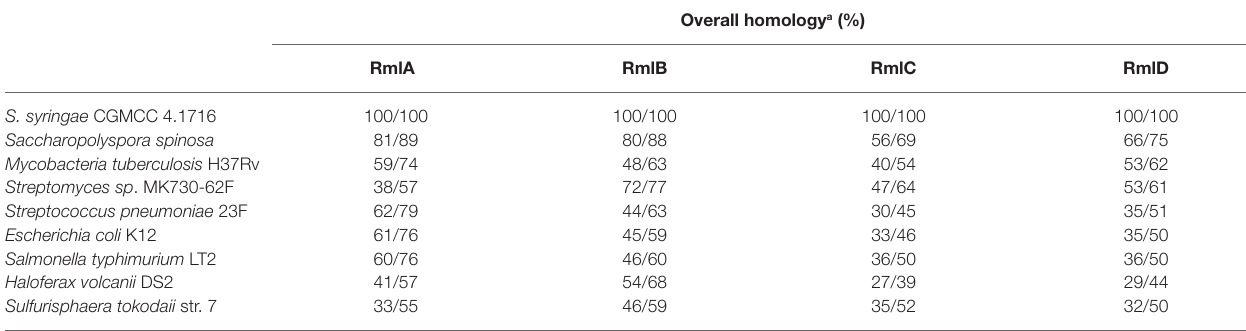
TABLE 1 | Overall homology of the predicted Ss-Rml enzymes from Saccharothrix syringae CGMCC 4.1716 with their homologs.